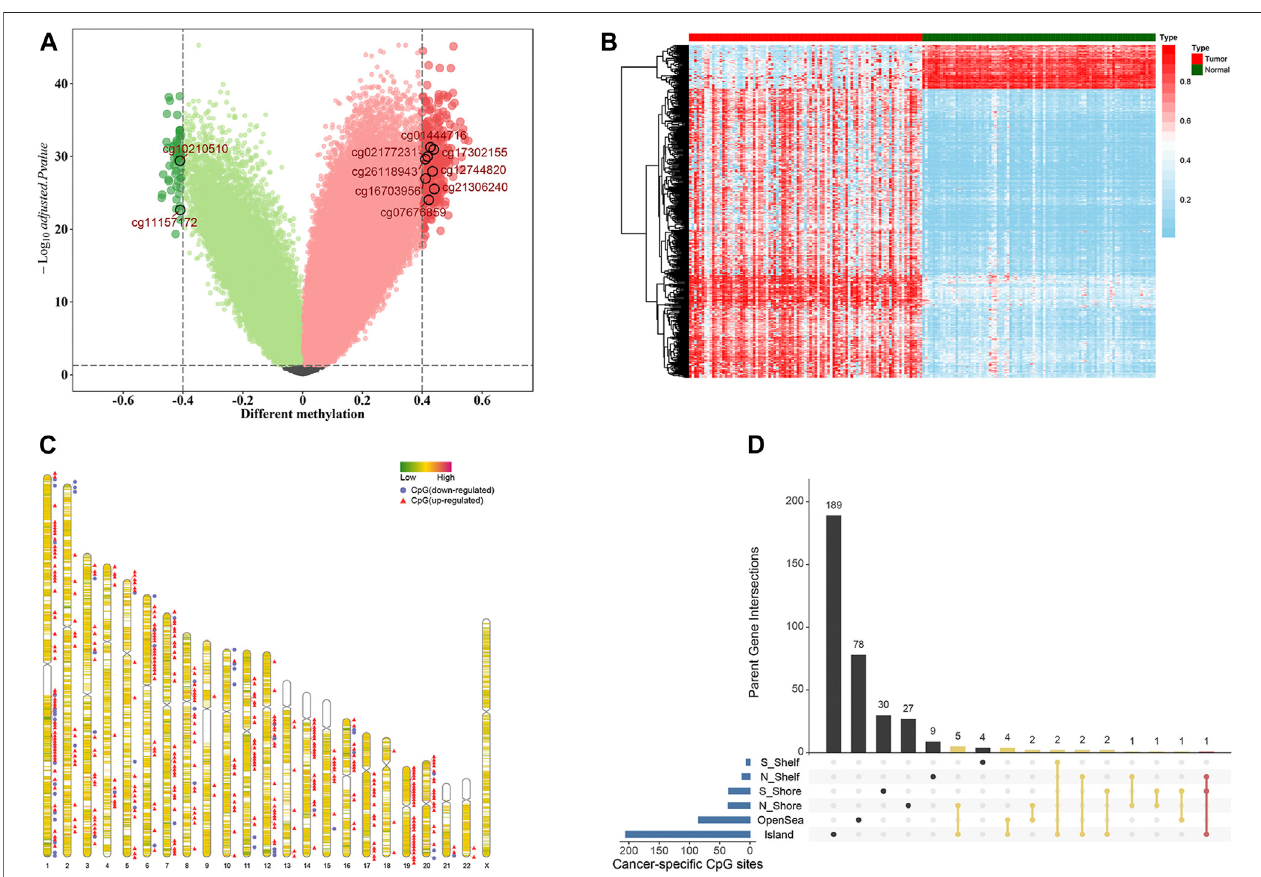
FIGURE2| SelectionofdifferentialmethylationCpGsitesinthediscoverystage( n (cid:1) 91pairs). (A) Volcanoplotwasgeneratedbasedonthedifferentialmethylation in combination with adjusted t -test p -values. The x -axis represents the differential methylation that the average methylation level in tumor tissues versus average value in adjacent normal tissues for each CpG site, while the y -axis represents the negative log10 transformation of adjusted p -values for each comparison. The vertical lines represent an absolute value of differential methylation of 0.4, and the horizontal lines indicate adjusted p -value (cid:1) 0.05. A total of 432 differentially methylated CpG sites with statistical signi fi cance were identi fi ed. Among them, 375 were up-regulated (red dots) and 57 were down-regulated (green dots). (B) Heatmap showing methylationof432CpGsitesinpaired tumor samplesandadjacentnormaltissues. (C) Idiogramvisualizingthegenome-wide informationofdifferentialmethylationCpG sites. (D) Upset plot depicting the region-level island-based distribution within parent genes of these 432 CpG sites.